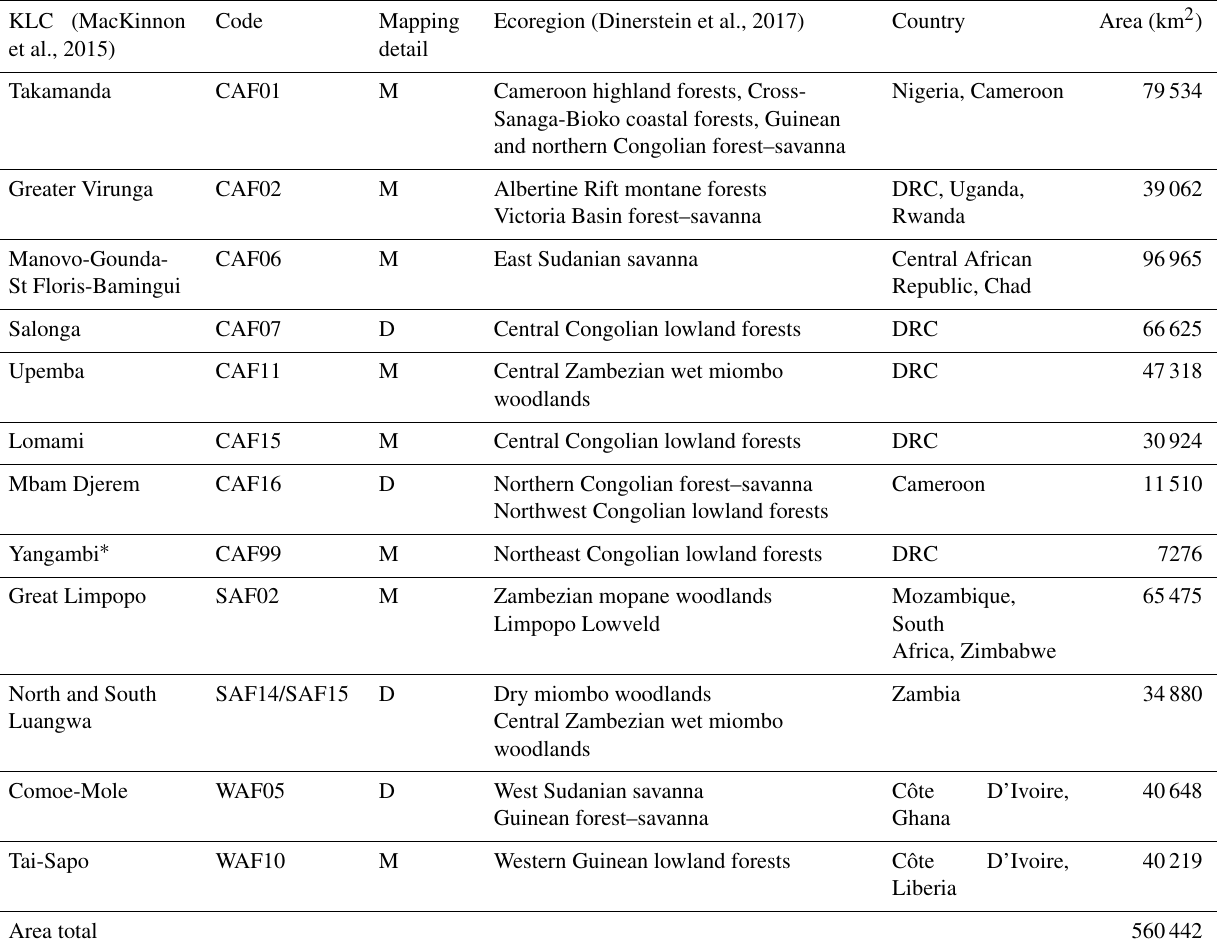
Table 1. Mapped key landscapes for conservation (KLCs) within phase 1. Mapping detail refers to the employed classification scheme – Dichotomous (D) and Modular (M); see it in the Data collection and mapping guidelines